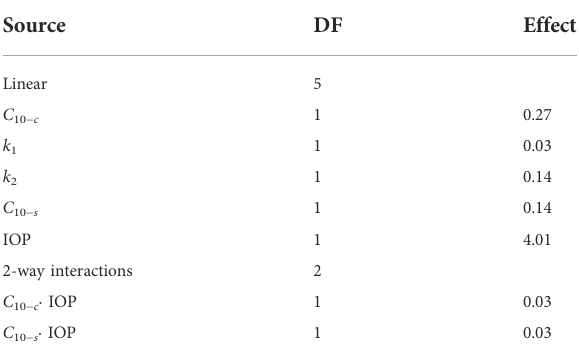
TABLE 4 Analysis of variance (ANOVA) results on the de fl ection amplitude. Degrees of freedom (DF) and Effect size.